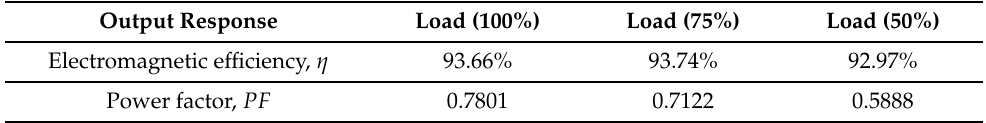
Table 9. Comparison of electromagnetic efficiency and power factor for various load points of the optimal design 3-variable optimization problem.